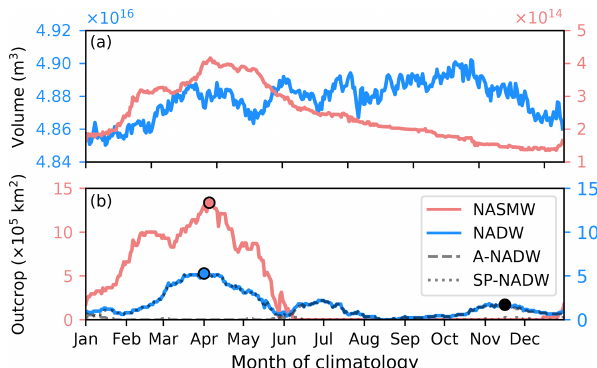
Figure 5. Mean-year time series of NADW (blue) and NASMW (red) (a) volume and (b) outcrop surface area including those of the Arctic (dashed line) and subpolar (dotted line) NADW outcrops from the nonlinear trajectory. Circles indicate the injection time of NASMW (red), NADW (blue), and A-NADW (black) in the for- ward simulations (see Sects. 3.2 and